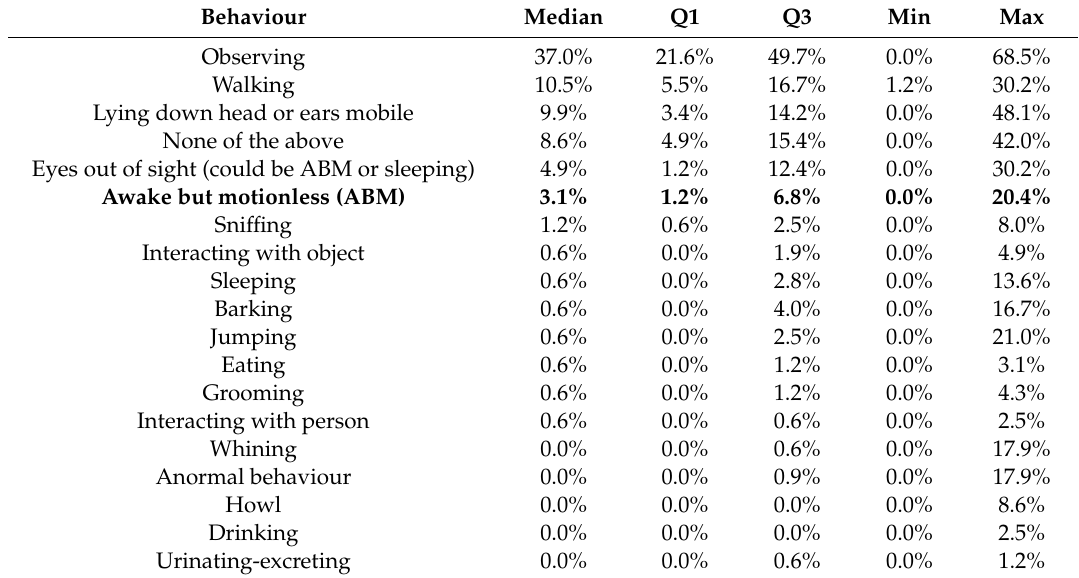
Table 3. Median percentage of scans, first (Q1) and third (Q3) quartiles and minimum (min) and maximum (max) values for behaviour in the home-pen (n = 43 dogs). The behaviour are ordered from the longest to the shortest median times spent displaying them, and the behaviour we hypothesise to specifically reflect depression is highlighted in